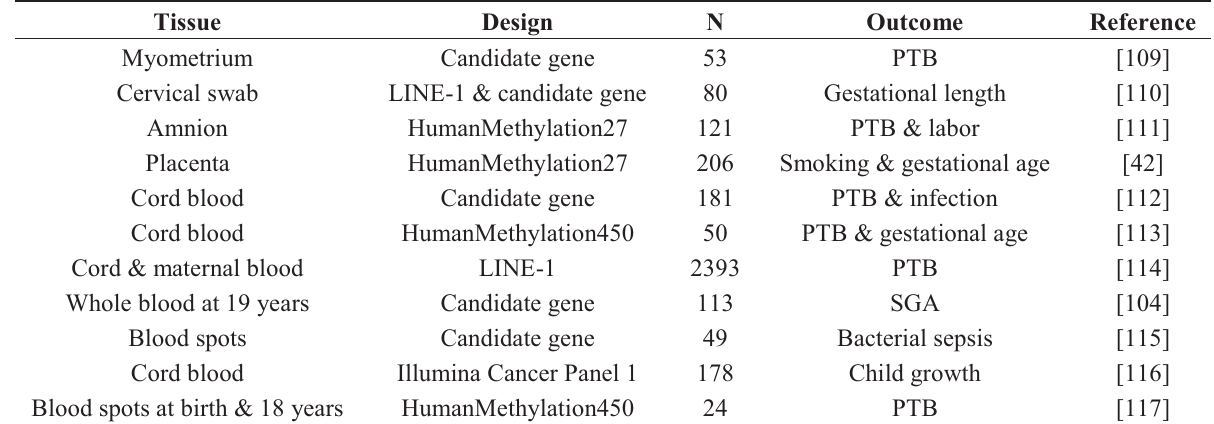
Table 1. Overview of DNA methylation studies of